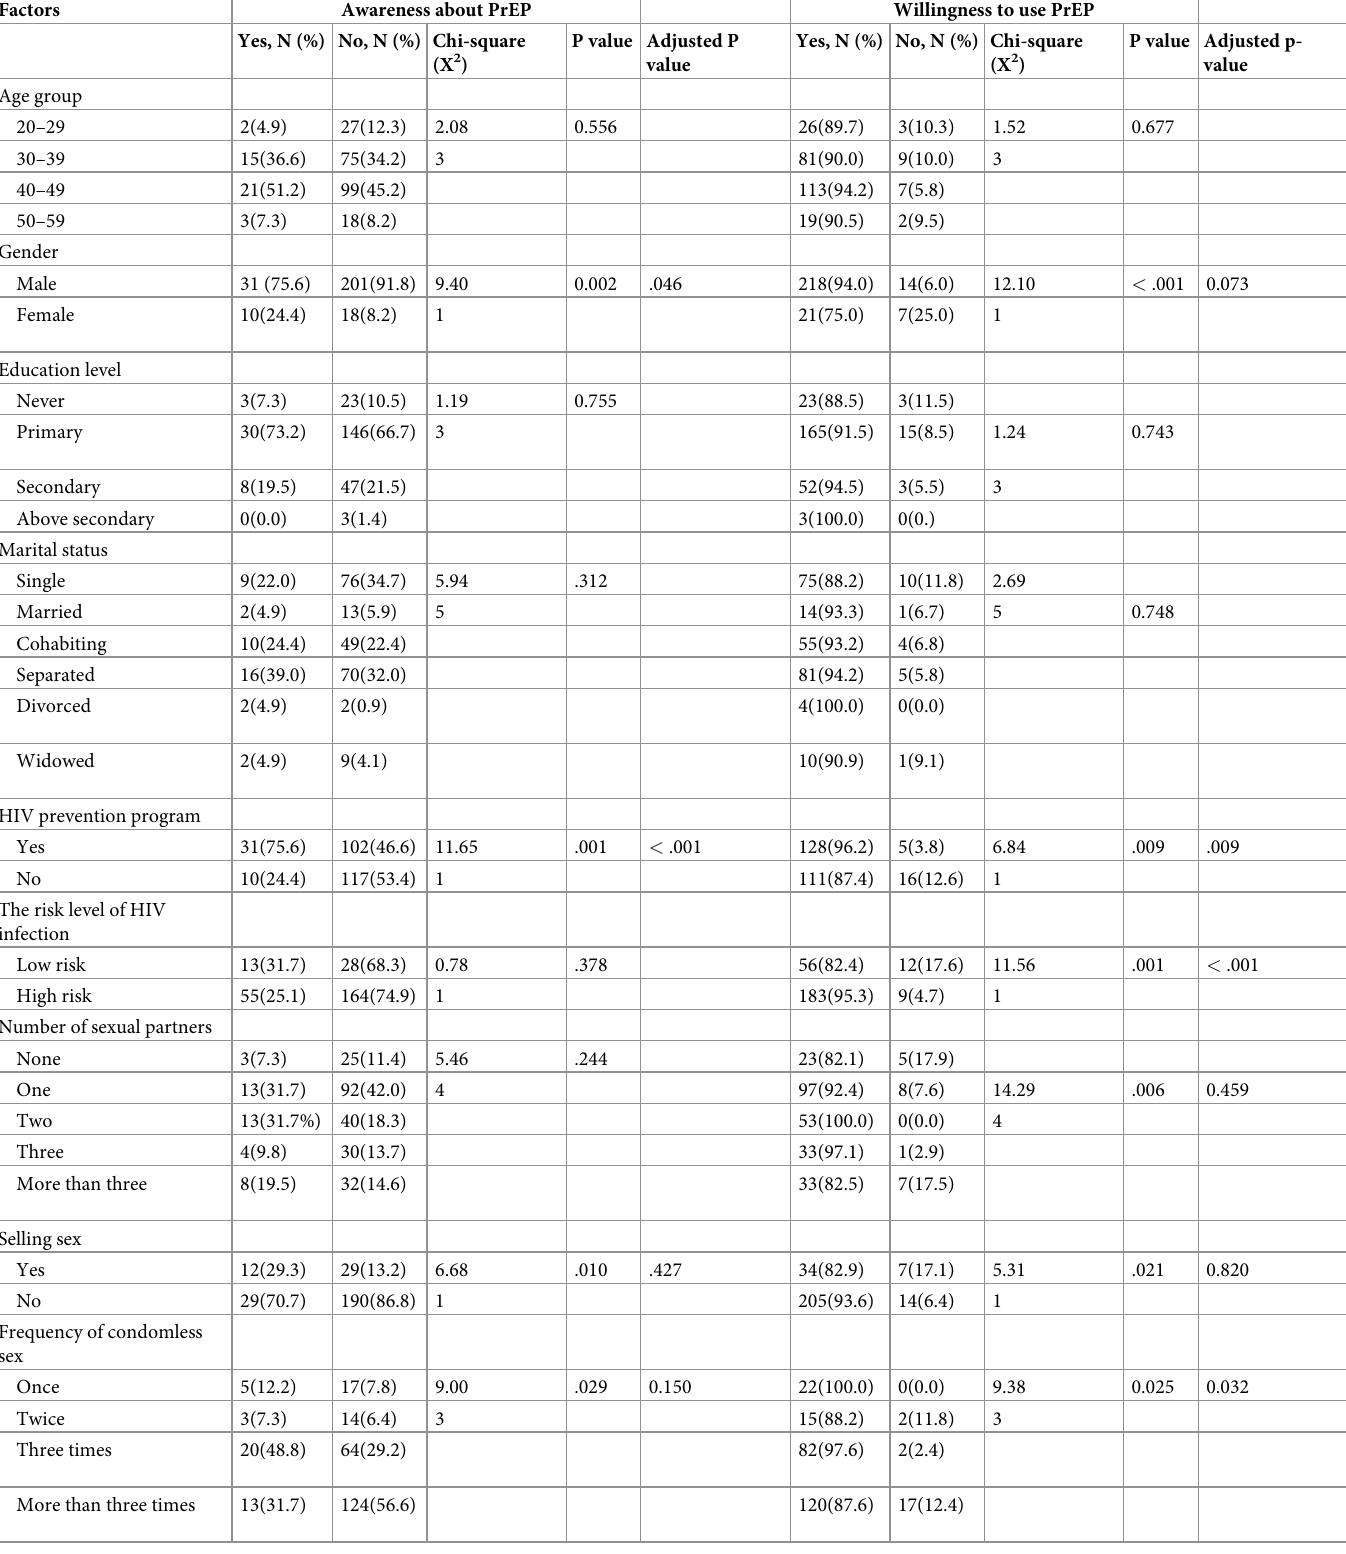
Table 5. Factors associated with awareness and willingness to use PrEP among the